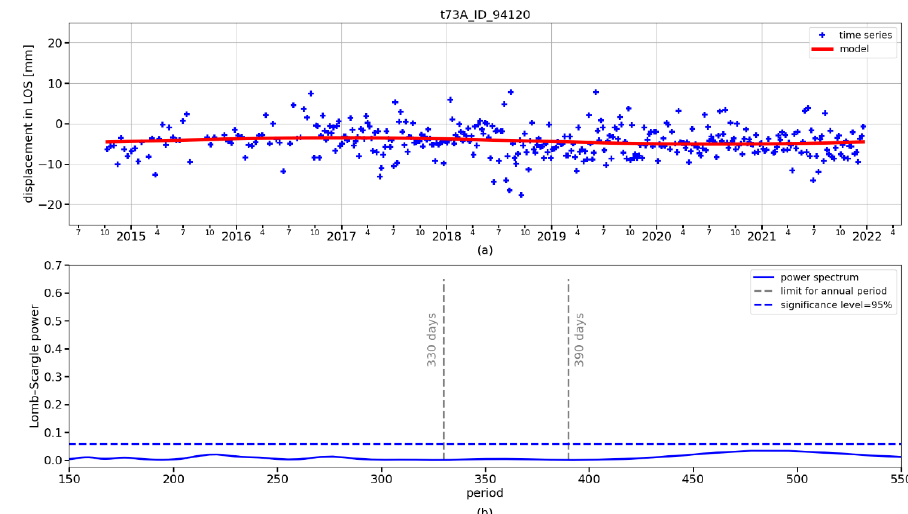
Figure 6. Time series of PS point 94120 (track A73) displacement in LOS and model based on periodogram ( a ) and corresponding Lomb–Scargle periodogram ( b ).